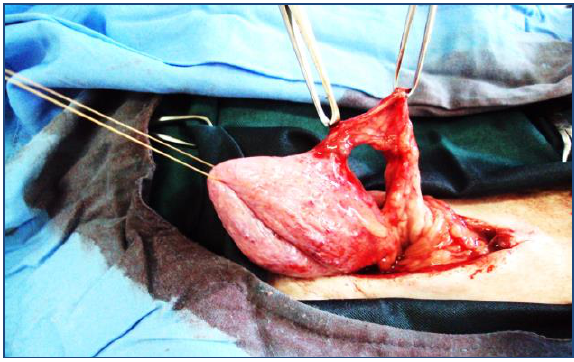
Figure, 5: Show's the adhesion between omentum and bladder wall in a dog related to inverting